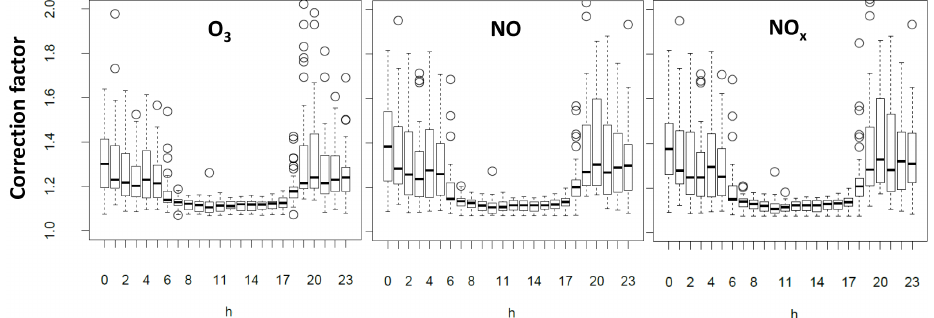
Figure 2. Hourly averaged high-frequency loss correction factors for O 3 , NO and NO x over the 15 August–7 September 2012 period determined with the in situ ogive method. The corrected flux equals the measured flux multiplied by the correction factor. Black bars are medians, boxes show the interquartile, error bars show the minimum and maximum of the whisker and empty dots shows the